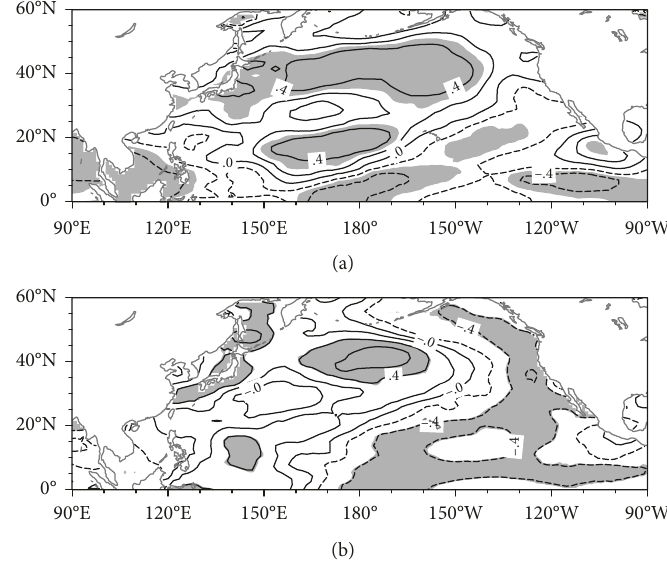
Figure 6: Same as Figure 5, but for (a) 1948–1990 and (b)